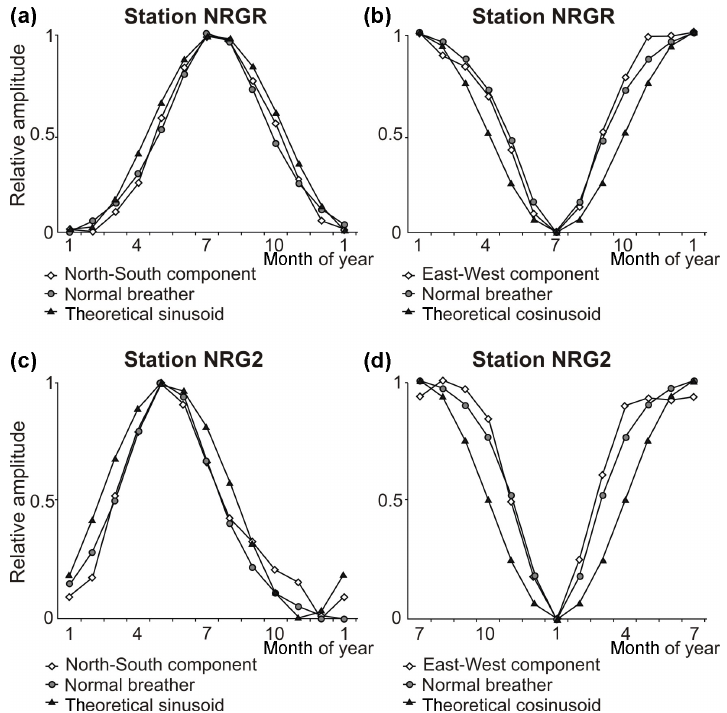
Figure 5. Seasonal variations of NRGR and NRG2 station positions. Approximation of the observed displacement curves by the theoretical curves for the N–S (a) and E–W (b) components at the NRGR site, and for the N–S (c) and E–W (d) components at the NRG2